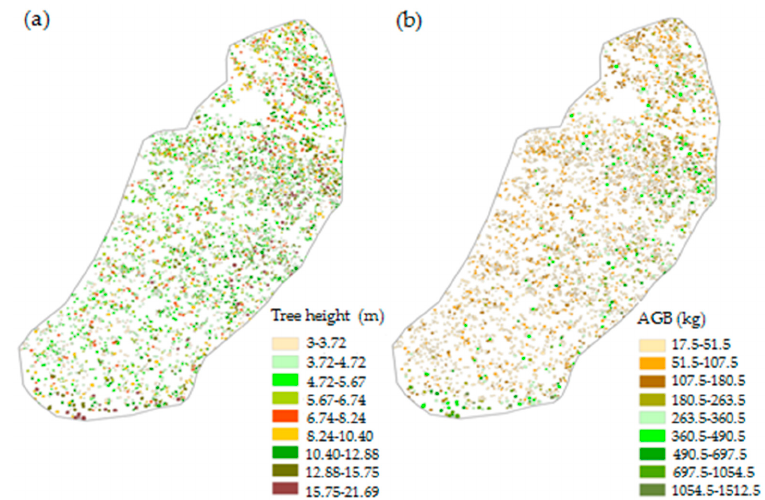
Figure 11. The identified Minjiang fir trees and their heights, and the estimated AGBs of individual trees.